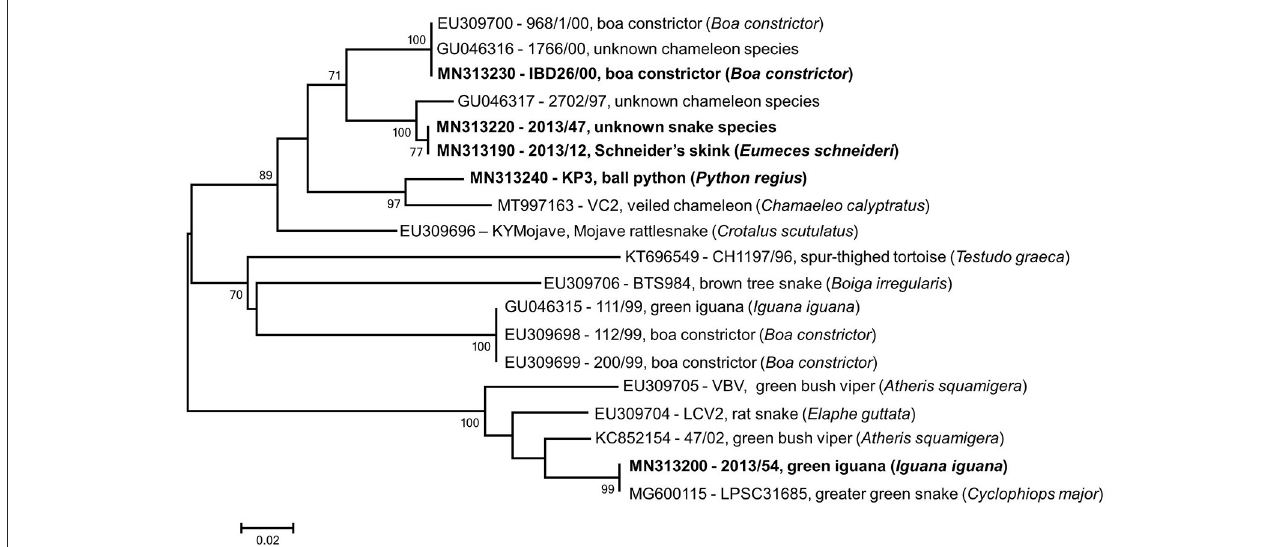
FIGURE4 Phylogenetic tree based on partial RdRp gene using overlapping regions of reference strains available in GenBank. Taxa are identified by accession number, strain name and host species; study strains are highlighted. The scale bar is proportional to the genetic distance. Bootstrap values greater than 60 are shown at the branch